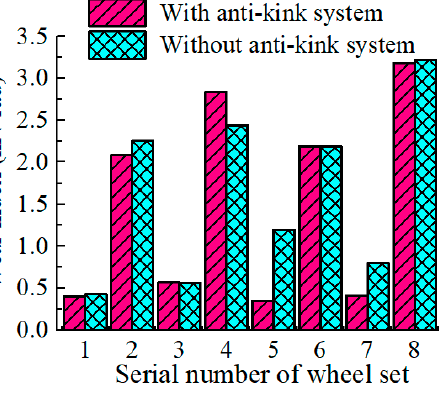
Figure 17. Wear index.